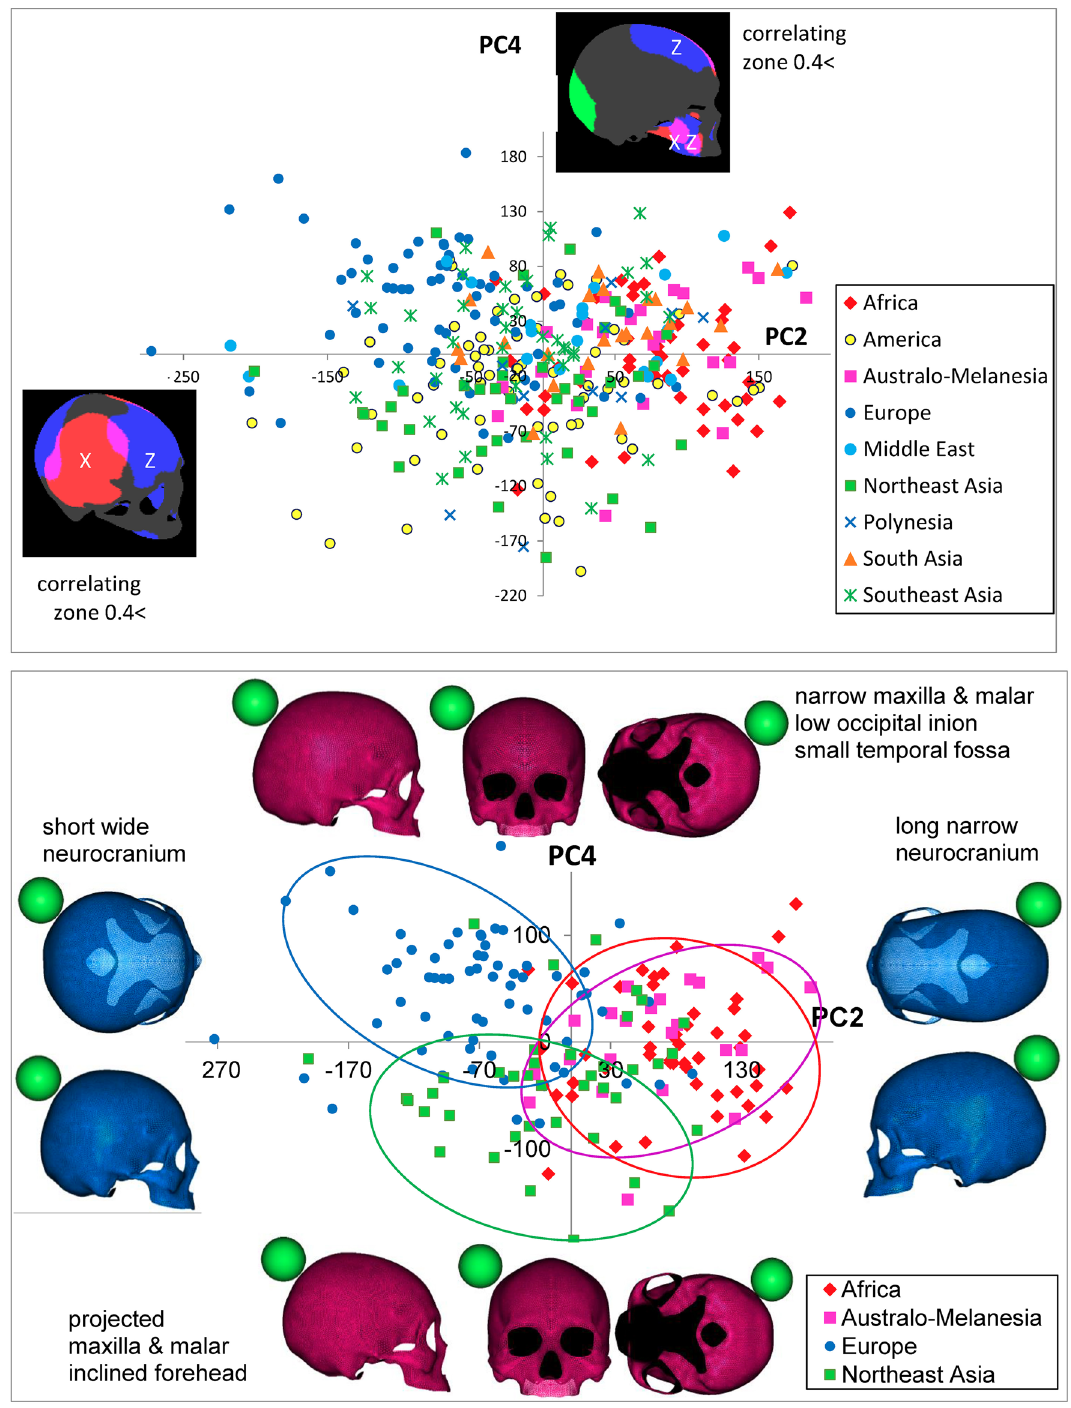
Figure 4. Scatter scoring diagrams of PC2 and PC4 for cranial individuals from nine geographical units (upper), and four geographical units (lower), color maps of cranial surface highly correlating vertices to each PC (interpretation of color against X, Y, Z axis: see text), and virtual shape deformations with a magnitude of 3 SD at the opposite sides of these axes. The scale is given as a green colored sphere of 50 mm in